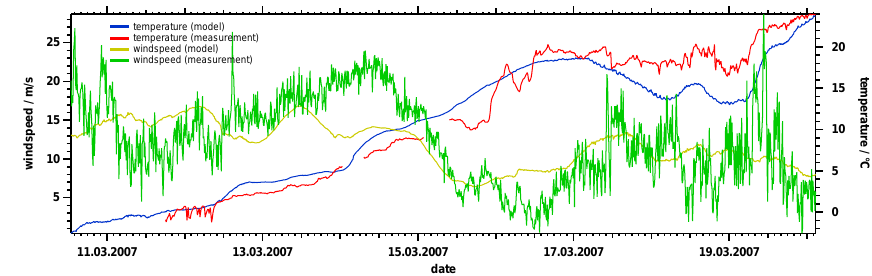
Figure 2. Time series of observed and simulated temperature and wind